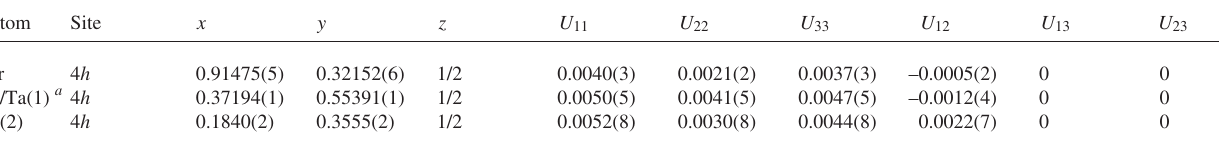
Table 3. Atomic coordinates and displacement parameters (in Å 2 ) .